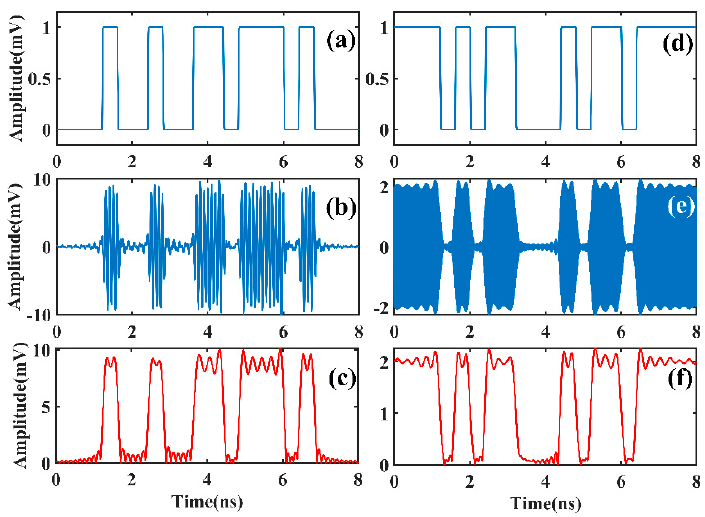
Figure 3. ( a , d ) The coding signal cos(cid:3427)𝛽 (cid:2872) 𝑠 (cid:3043) (𝑡)(cid:3431) , and waveform, envelope of ASK signals centered at 10 GHz ( b , c ), and 80 GHz ( e , f